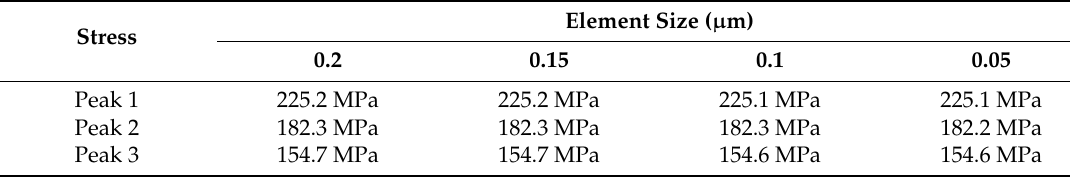
Table 2. List of peak stress under different element sizes.